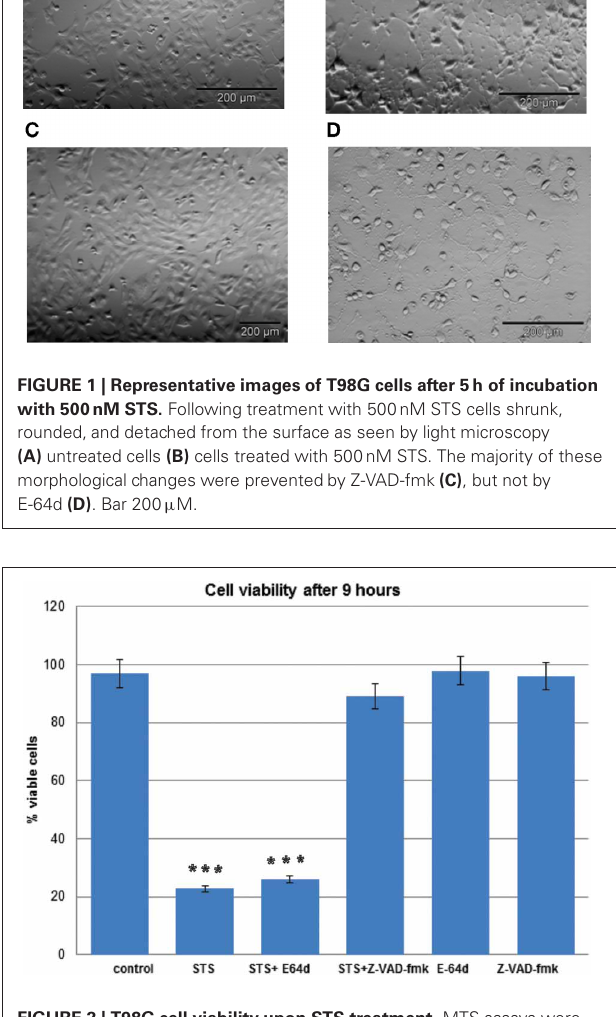
FIGURE 2 | T98G cell viability upon STS treatment. MTS assays were performed to measure the T98G cell viability after STS treatment. Data are expressed by the mean of percent cell viability compared to control after exposure for 9h ± standard deviation. The cell-permeable inhibitors E-64d or z-VAD-fmk were added in adequate concentrations in DMSO 1h prior to induction of apoptosis. The corresponding volume of DMSO was added to the control cells. Cell death was induced wih 500mM STS. The data are representative of three independent experiments. Statistical significance was analyzed by the Student’s t -test. A P -value ≤ 0.001 ( ∗∗∗ ) was considered significant.